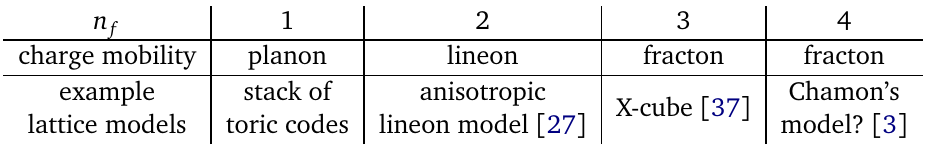
Table 1: Charge mobility (to be derived in Sec. 2.1.1) and example models that can be described by different numbers of foliations. It is expected [ 27 ] that n foliations can describe Chamon’s model [ 3 ] . (The checkerboard model is equivalent to two copies of the X-cube model [ 25 ] , and can therefore be described by two copies = 3 foliated field of the n f